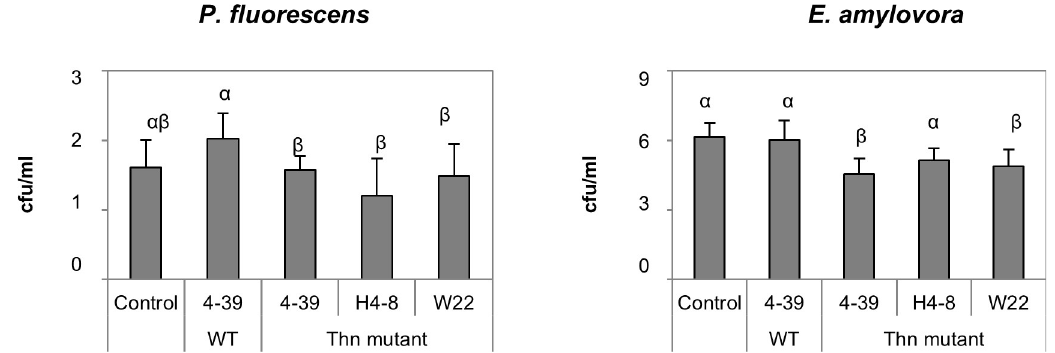
Fig 3. Effect of volatiles produced by S . commune wildtype and thn mutant strains on the growth of indicator bacteria. Data are presented as viable cell numbers (cfu ml -1 ) in 10 8 ; P < 0.05, n = 6.